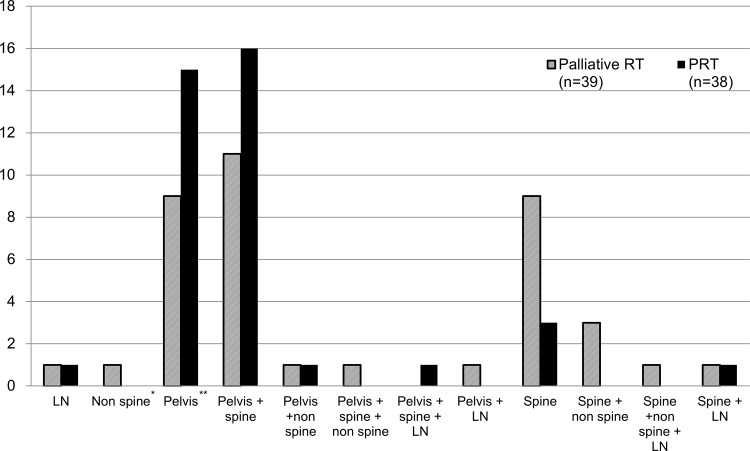
Extent and site of radiotherapy for patients receiving prostate radiotherapy (PRT) or palliative radiotherapy (RT).Non spine*: site of bone metastasis except in the pelvic bone and spine (C-T-L spine).Pelvis**: bone metastasis, including metastasis to the pubic, ischial, and iliac bones and the sacrum and proximal femur.